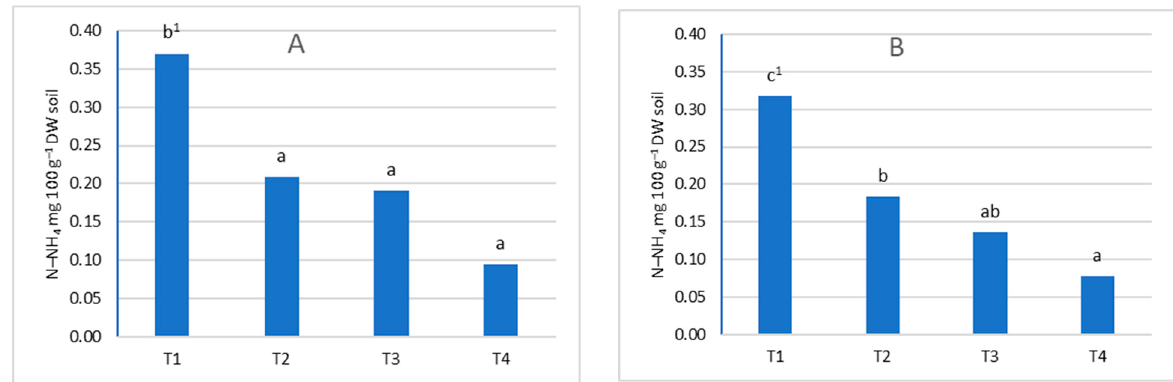
Figure 3. The content of N-NH 4 depends on the date of sampling ( A )—in the soil layer 0–20 cm, ( B )—in the soil layer 21–40 cm. The nitrogen determination: T1—term after flowering trees, T2—term during the intensive fruit growth, T3—term after fruit harvest in August, T4—term after the end of vegetation. 1 means that the same letters are not significantly different at α = 0.05 (Duncan’s test).